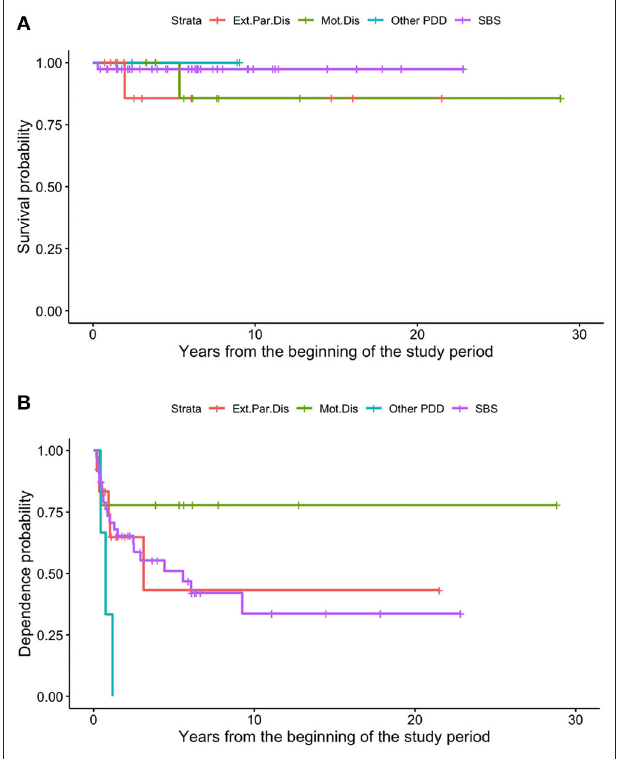
FIGURE 5 | Different survival (A) and dependence (B) rates of patients on HPN because of primary CIF, based on the underlying disease.